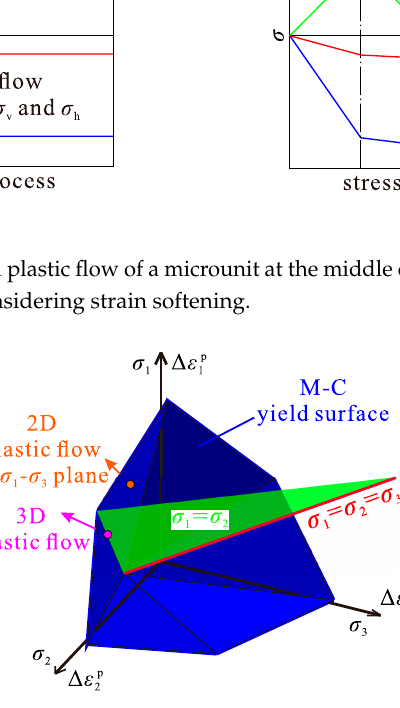
Figure 3. 2D plastic flow and 3D plastic flow